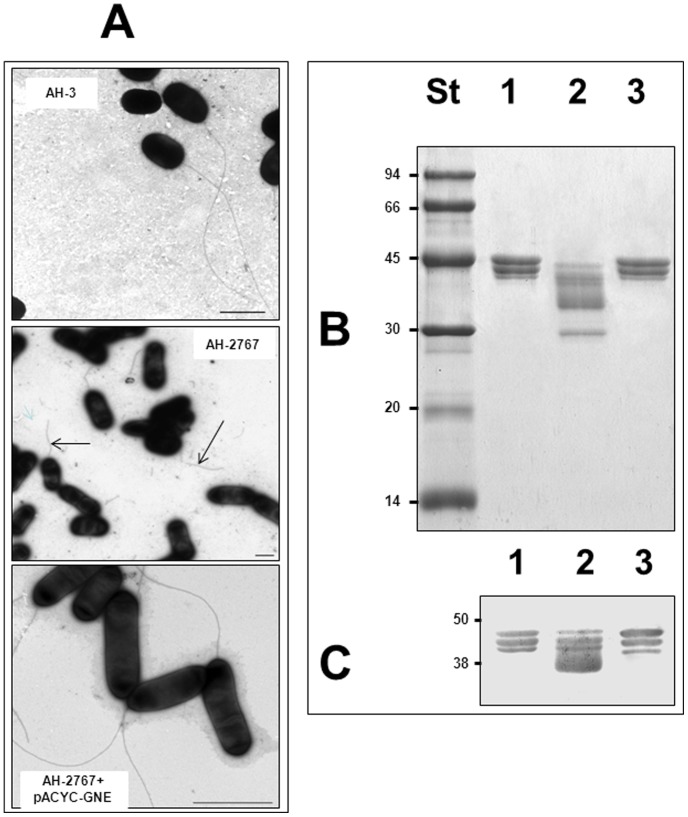
A/Electron microscopy of whole cells from A. hydrophila strains stained according to Experimental Procedures.Bar represents 1μ. B/SDS-PAGE of purified polar flagellins. C/Western blot using specific antiserum against purified polar flagellins. St, size standard. 1, A. hydrophila AH-3 (wild type); 2, A. hydrophila AH-2767 gne mutant; and 3, A. hydrophila AH-2767 mutant complemented with plasmid pACYC-GNE (19). D/Western blot using specific antiserum against GlcNAc. Lanes: 1, A. hydrophila AH-2767 gne mutant; 2, A. hydrophila AH-3 (wild type); and 3, AH-3ΔWecP mutant. The arrows in 2A pointed out the more short and fragile flagellum of the mutant versus the wild type flagellum.